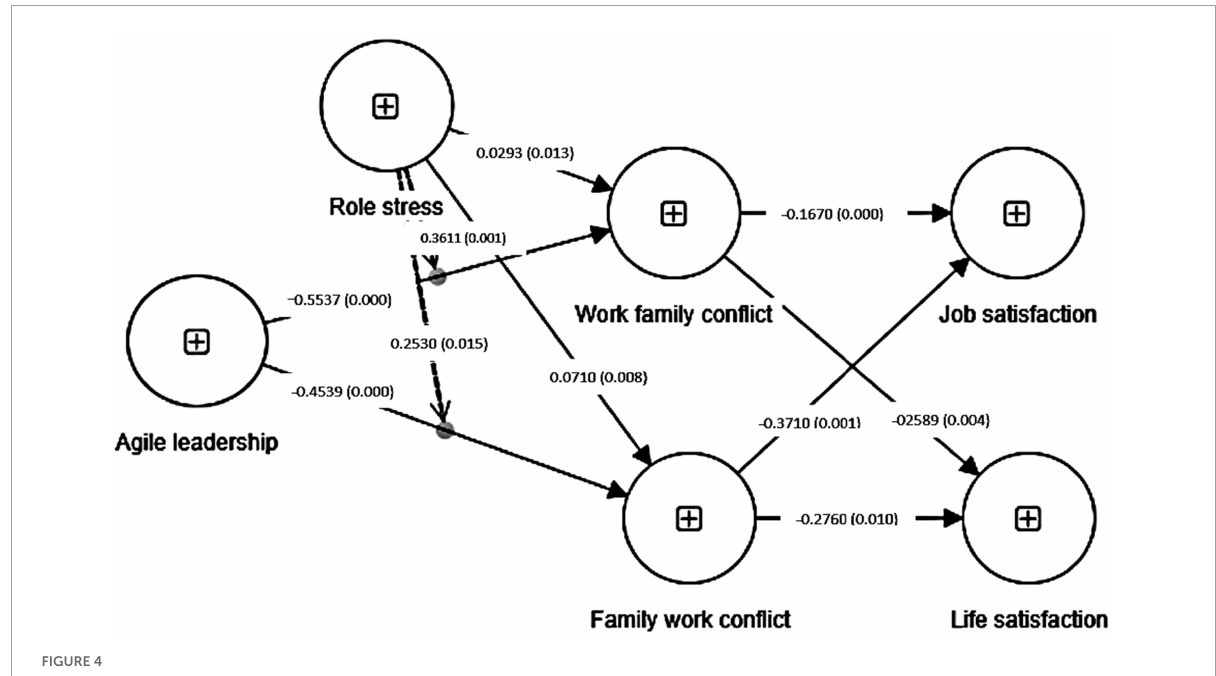
FIGURE4 Structural